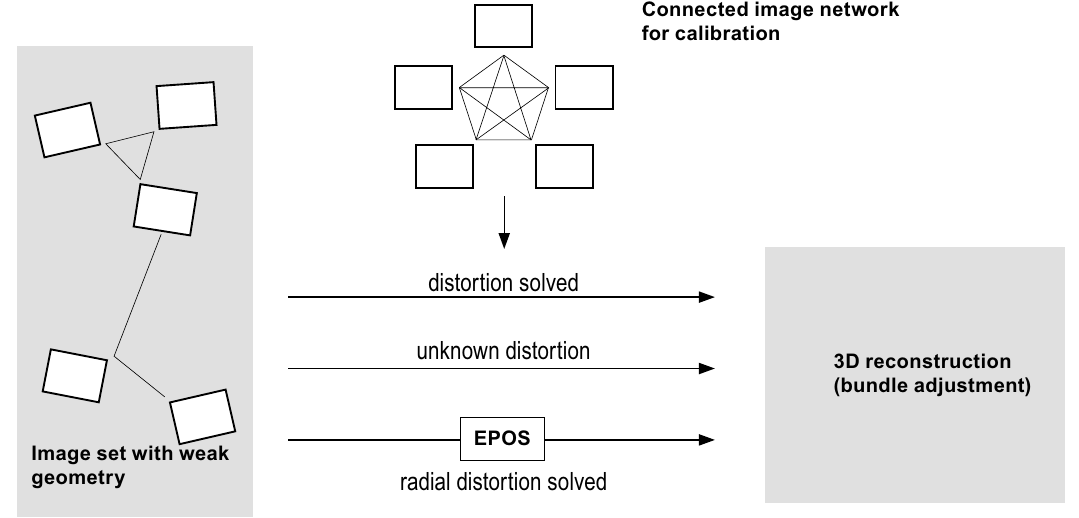
Figure 1. The proposed method, and its implementation EPOS, introduce a new automated ‘black-box’ paradigm in solving lens distortion for image sets with weak geometry, compared to the existing alternatives of either using a pre-calibrated camera (top arrow) or employing a non-linear distortion correction term inside bundle adjustment (middle